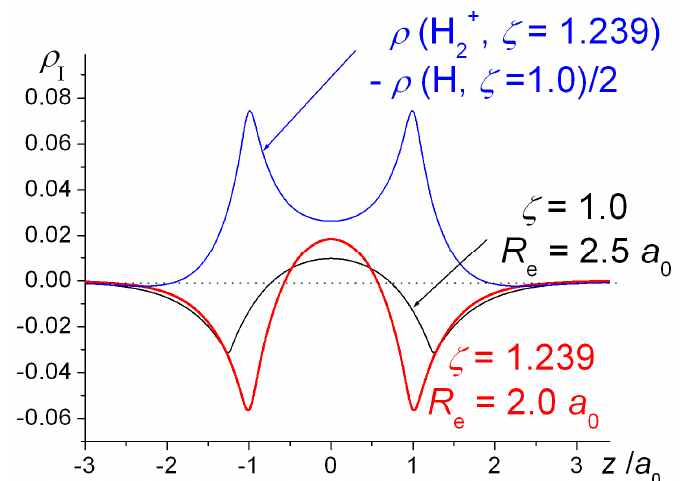
Figure 4. Interference density in H 2 + for optimized exponent ζ = 1.239 and bond length R e = 2.0 a 0 (red line), with nuclei at z = ± 1 a 0 , compared with interference densities for ζ = 1 and R e = 2.5 a 0 (black line) and relative to H atoms with ζ = 1 (blue line) as functions of the internuclear coordinate z .